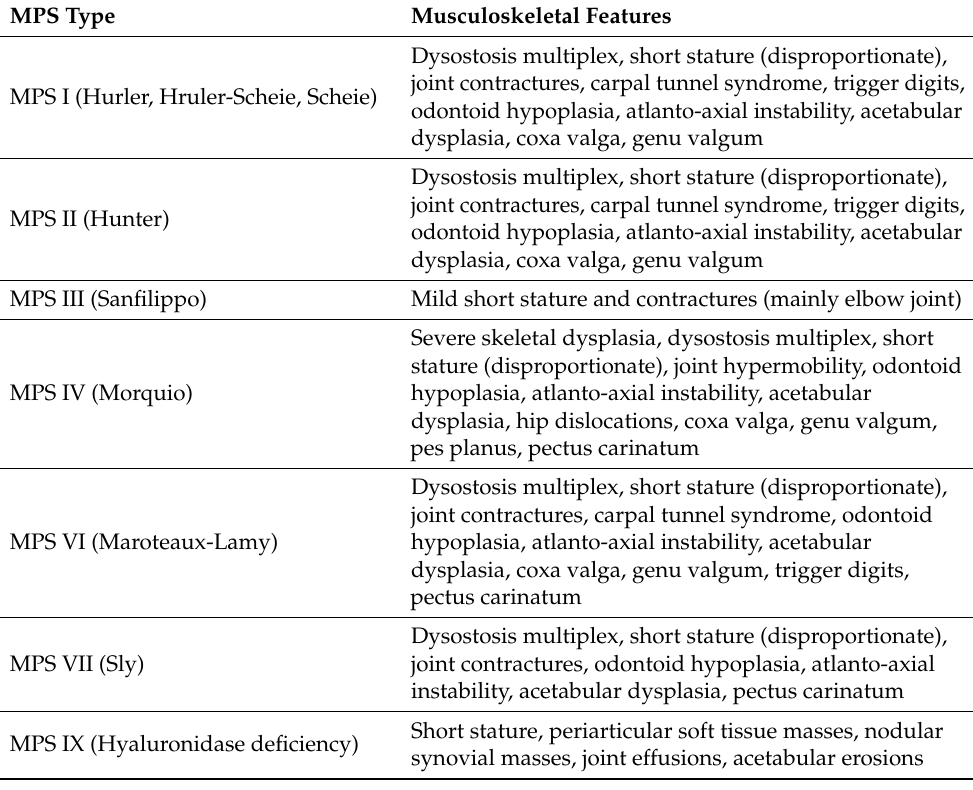
Table 2. Musculoskeletal features of MPS.